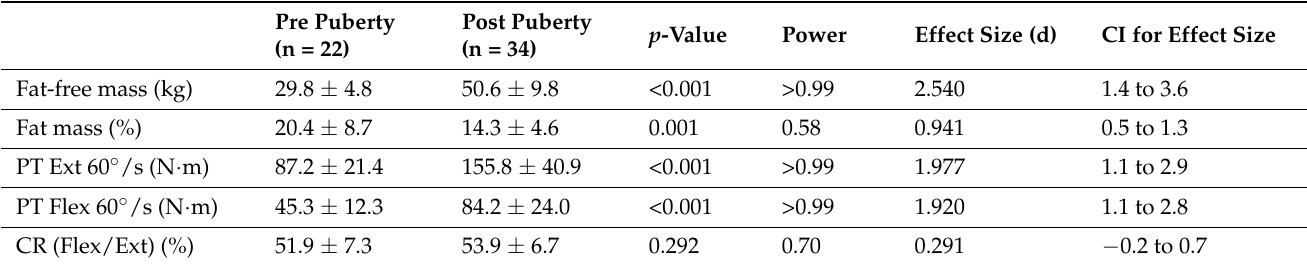
Table 3. Body composition and strength values for the boys’